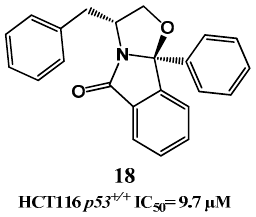
Figure 6. Oxazoloisoindolinone derivative 18 .